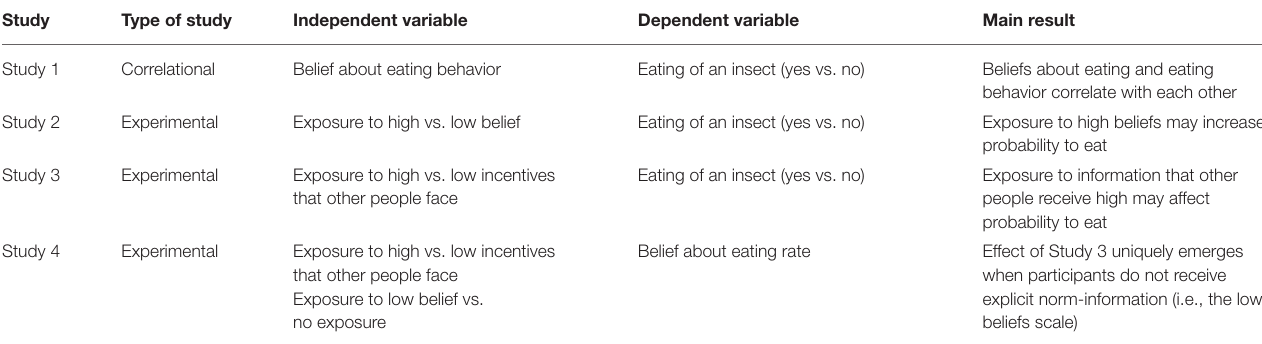
TABLE 5 | Summary of